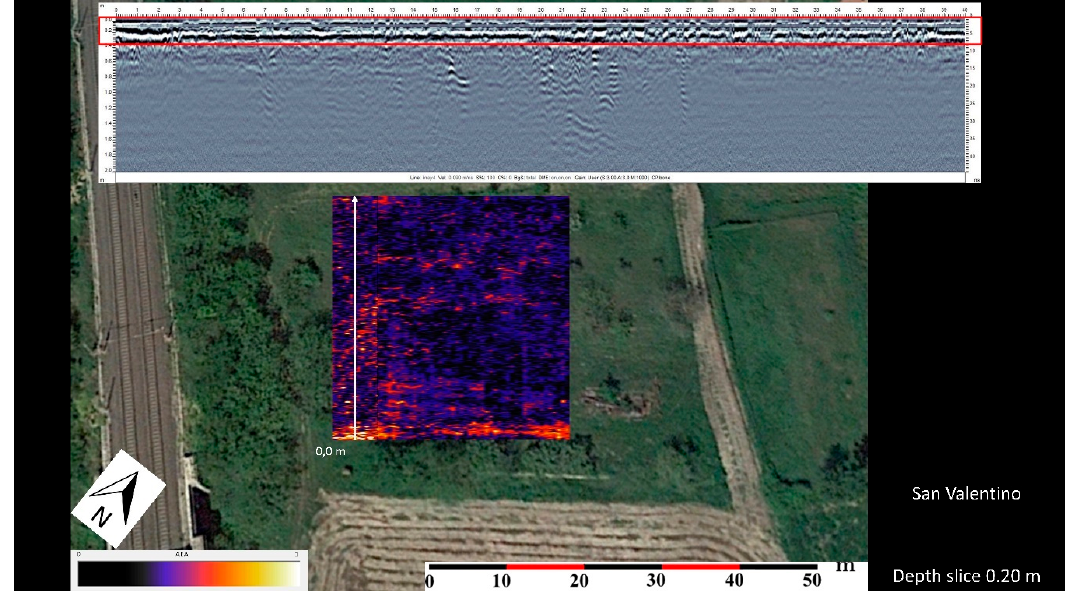
Figure 6. The ground-penetrating radar (GPR) map at 0.2 m depth, in which the anomaly parallel to the visible wall can be seen. Above is the radargram collected along the white arrow, with a red rectangle indicating the relative depth of the map.